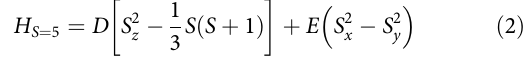
The fi rst term represents the isotropic exchange interaction, the second one contains the anisotropic part of intramolecular high spin 3 d 5 ions, while the third one takes into account single ion magnetic anisotropy. Nearest-neighbour antiferromagnetic exchange interactions between the central ( i = 1) and peripheral ( i = 2, 3, and 4) ions provide the leading term responsible for the ground S = 5 molecular state. This state features a ferrimagnetic- like arrangement of the spins, with the central and peripheral spins pointing in opposite directions (Fig. 1b). Because of